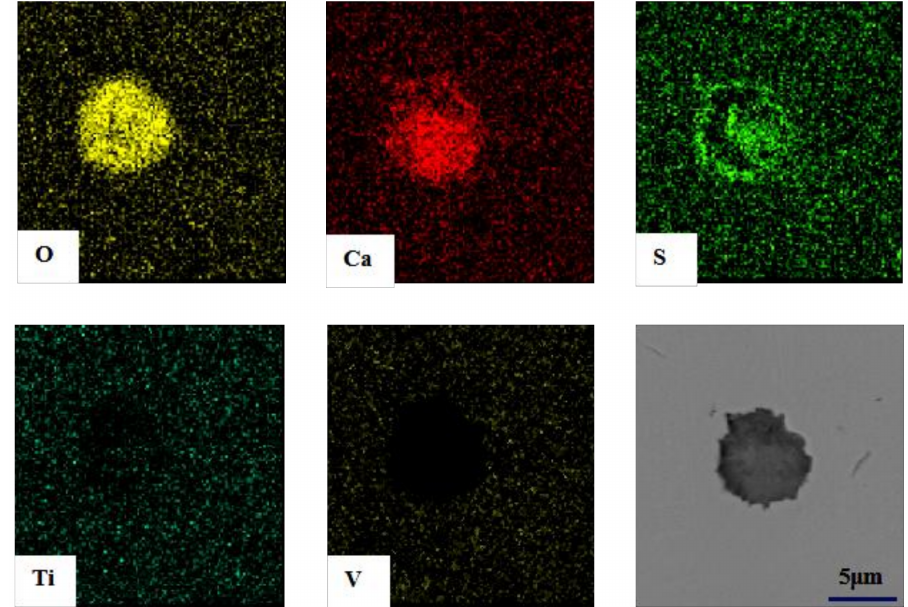
Figure 5. Element mappings showing CaS growth on CaO